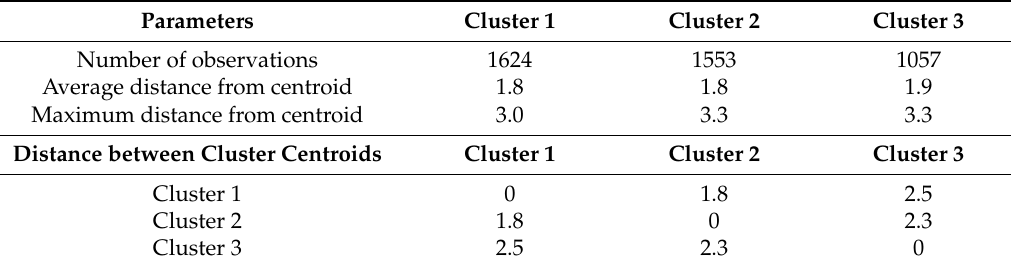
Figure 3. Means and standard errors (error bars) of the postural discomfort by the 45 combined posture codes in terms of the neck, trunk, and knee flexion angles. They are sorted from the largest postural discomfort to the smallest one. Table 3. Results of the cluster analysis, where the number of observations, average and maximum distance ( σ ) from the centroid of each cluster, and the distance ( σ ) between the cluster centroids are summarized.